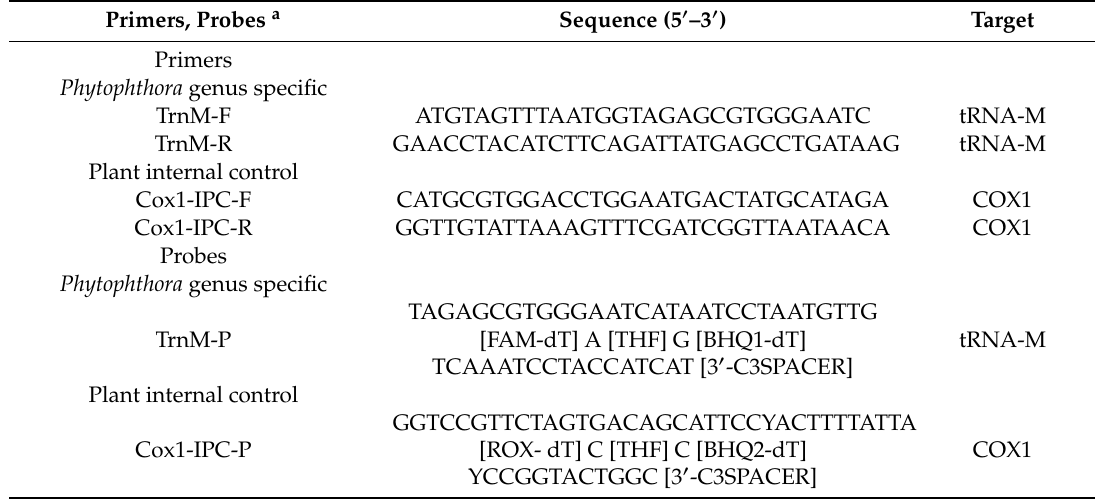
Table 6. Primers and probes used in this study for Phytophthora genus-specific detection and plant internal